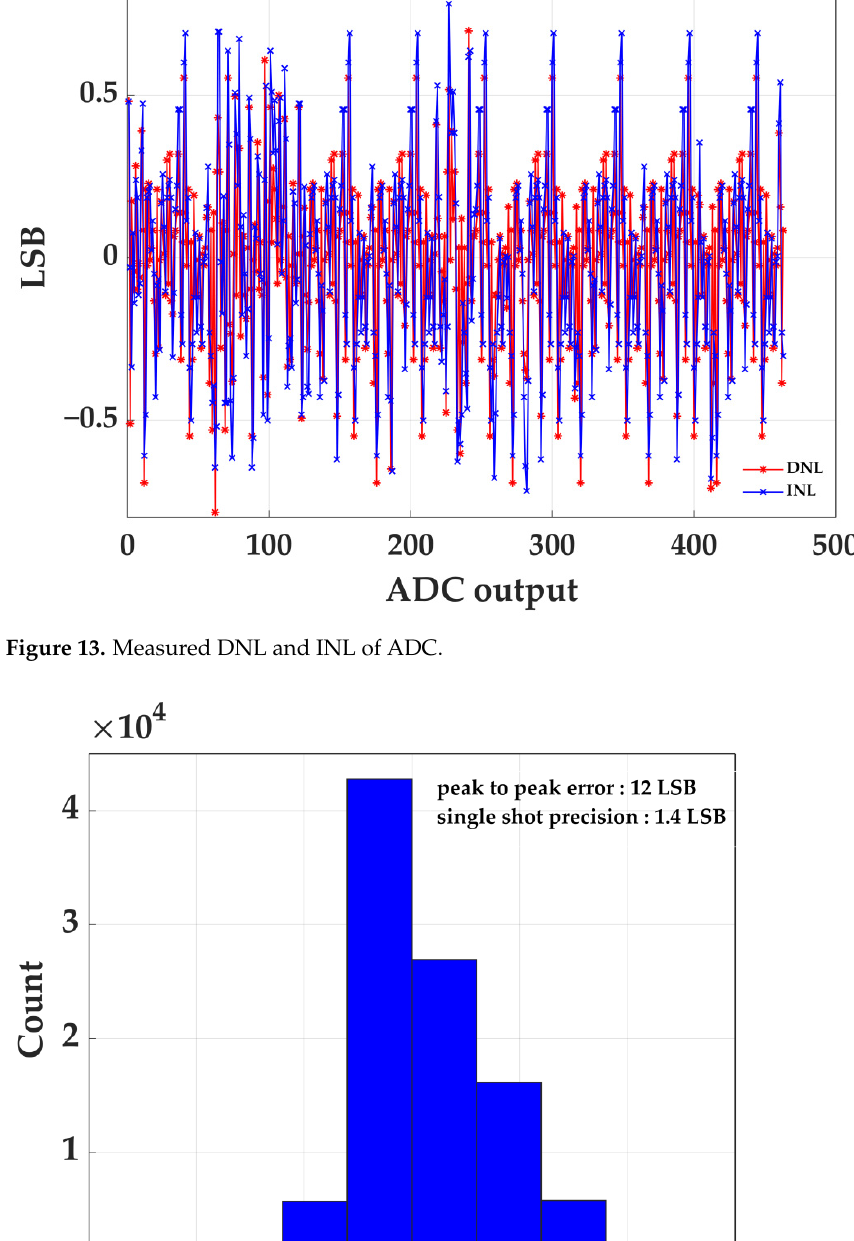
(b) Figure 12. Measured histogram in the carry chain ( a ) rising edge; ( b ) falling edge.